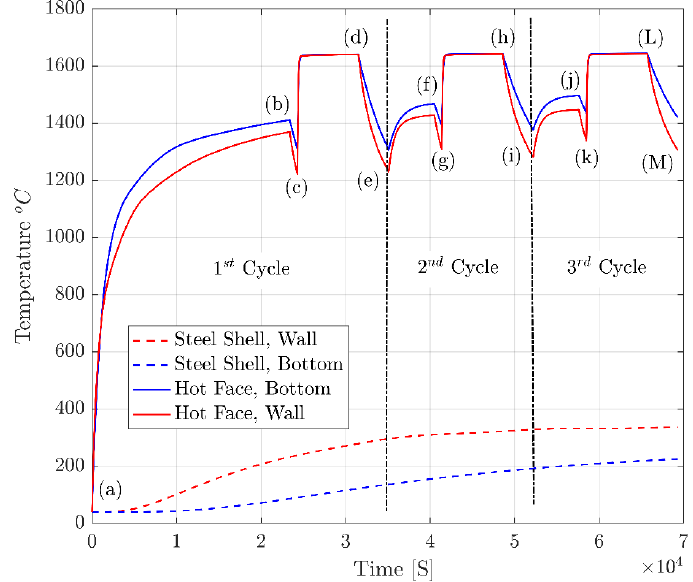
Figure 7. Temperature evolution of inner surface of working lining wall, and bottom and outer surface of steel shell during the first three thermal cycles of steel ladle. Ceramics 2020 , 2 FOR PEER REVIEW 12